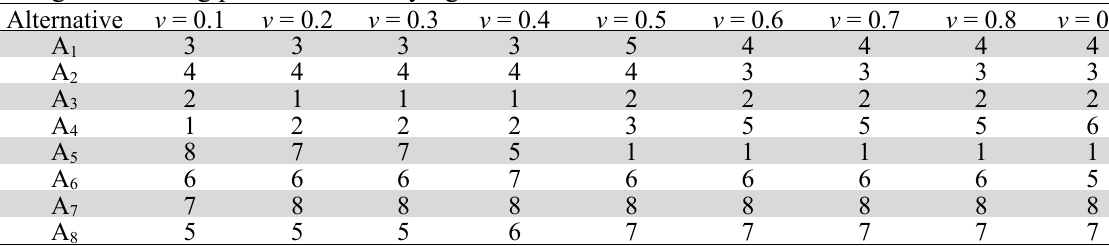
Changes in ranking patterns with varying v values in interval VIKOR method Alternative